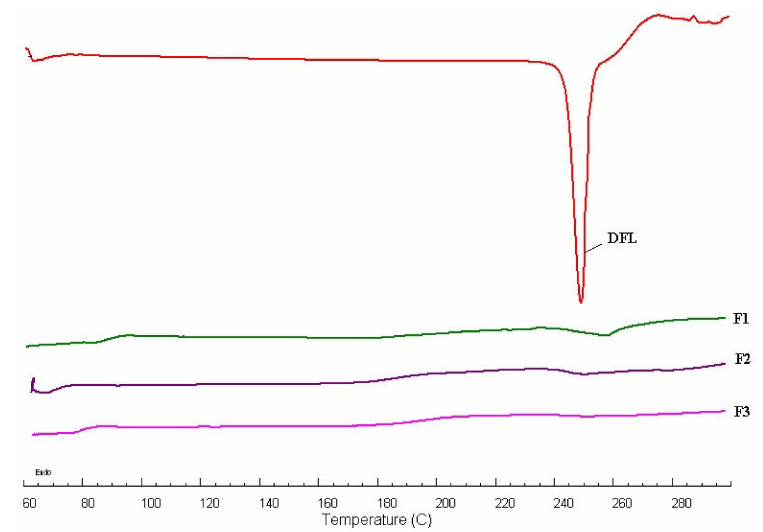
Figure 1. A comparative di ff erential scanning calorimetry (DSC) spectrum of pure delafloxacin